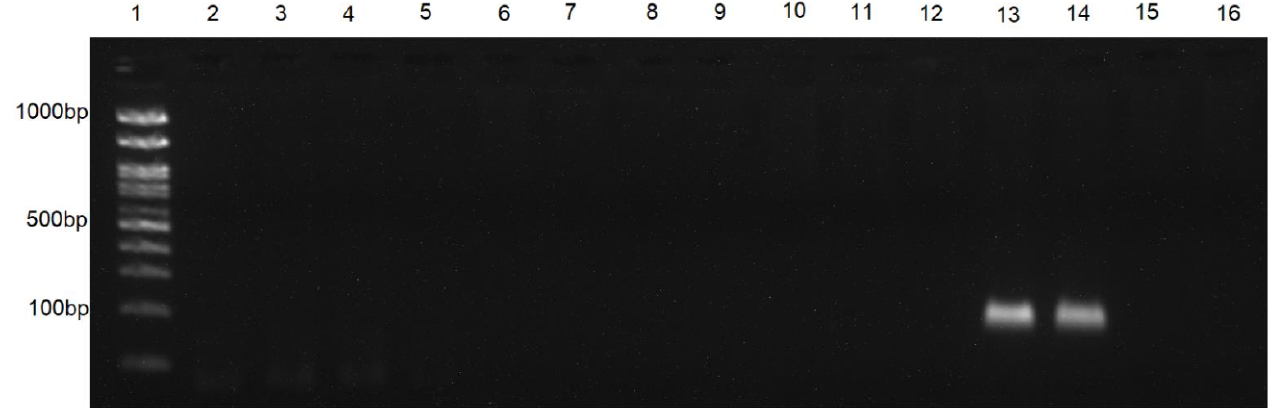
Figure 2. Electrophoresis gel showing the specificity of the primers Spo_frugi-F and Spo_frugi-R when tested with a PCR assay using DNA from different predators, months, and Spodoptera frugiperda . Column 1, ladder; columns 2–12, DNA of Hippodamia convergens, Doru luteipes, Harmonia axyridis, Cycloneda sanguinea, Anticarsia gemmatalis, Helicoverpa zea, Dalbulus maidis, Ephestia kuehniella, Spodoptera albula, Spodoptera cosmioides, and Spodoptera eridania , respectively. Column 13, DNA of S. frugiperda ; column 14, gut contents of H. convergens that had fed on S. frugiperda ; column 15, DNA of Spodoptera dolichos ; column 16, negative control.